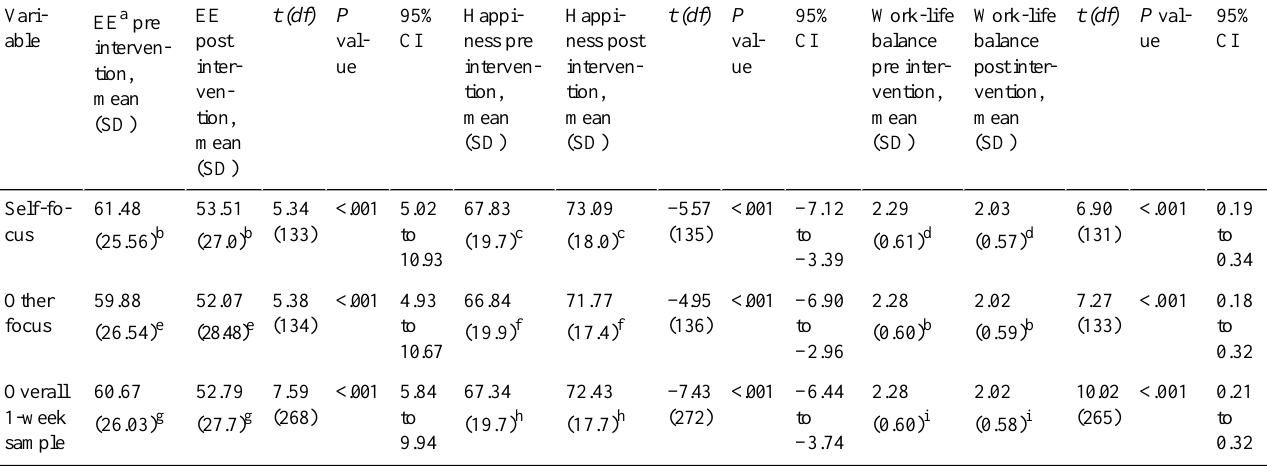
Table 3. Paired-samples t tests assessing well-being across participants who completed the self-focus condition, other-focus condition, and the overall sample at baseline and the 1-week